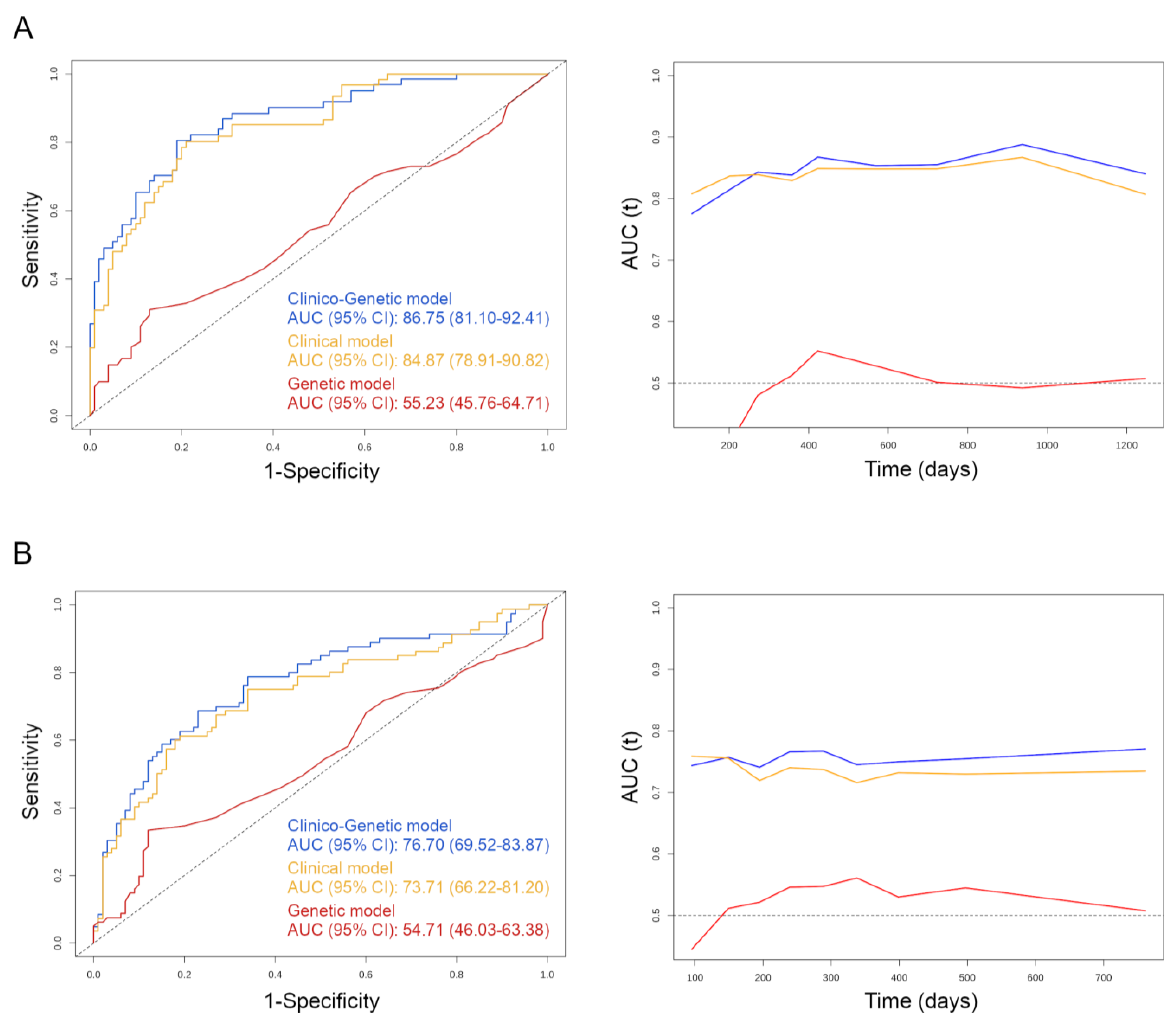
Figure 4. Discriminatory performance of the three mCRC biomarker models for predicting clini- cal outcomes of patients. ( A ) Time – dependent estimates of the AUC ( left ) for prediction of overall survival, visualized on ROC curves for each of the three biomarker combinations, alongside a dia- gram ( right ) displaying the temporal evolution of the AUC value for the different models. ( B ) Same performance metrics for discerning those patients at risk of progression.